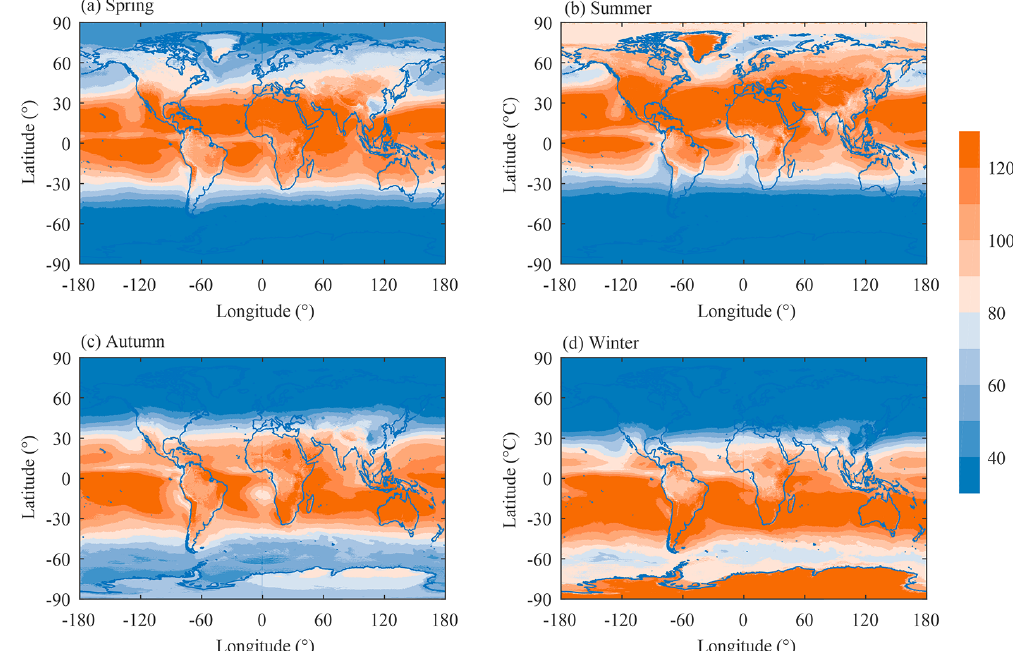
Figure 11. Spatial distribution of seasonal mean PAR between 2001 and 2018 derived from our estimated PAR product (ISCCP-ITP). The unit of PAR is Wm − 2